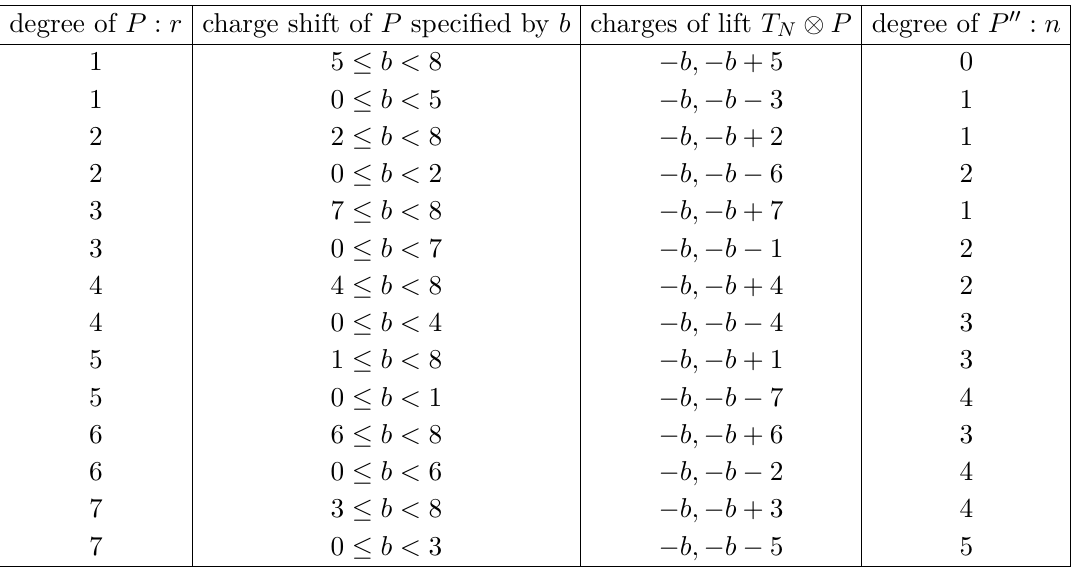
Table 1 . Summary of action of transition defect RG 0 between Landau-Ginzburg orbifold models X 8 / Z 8 and P 5 / Z 5 on rank-1-matrix